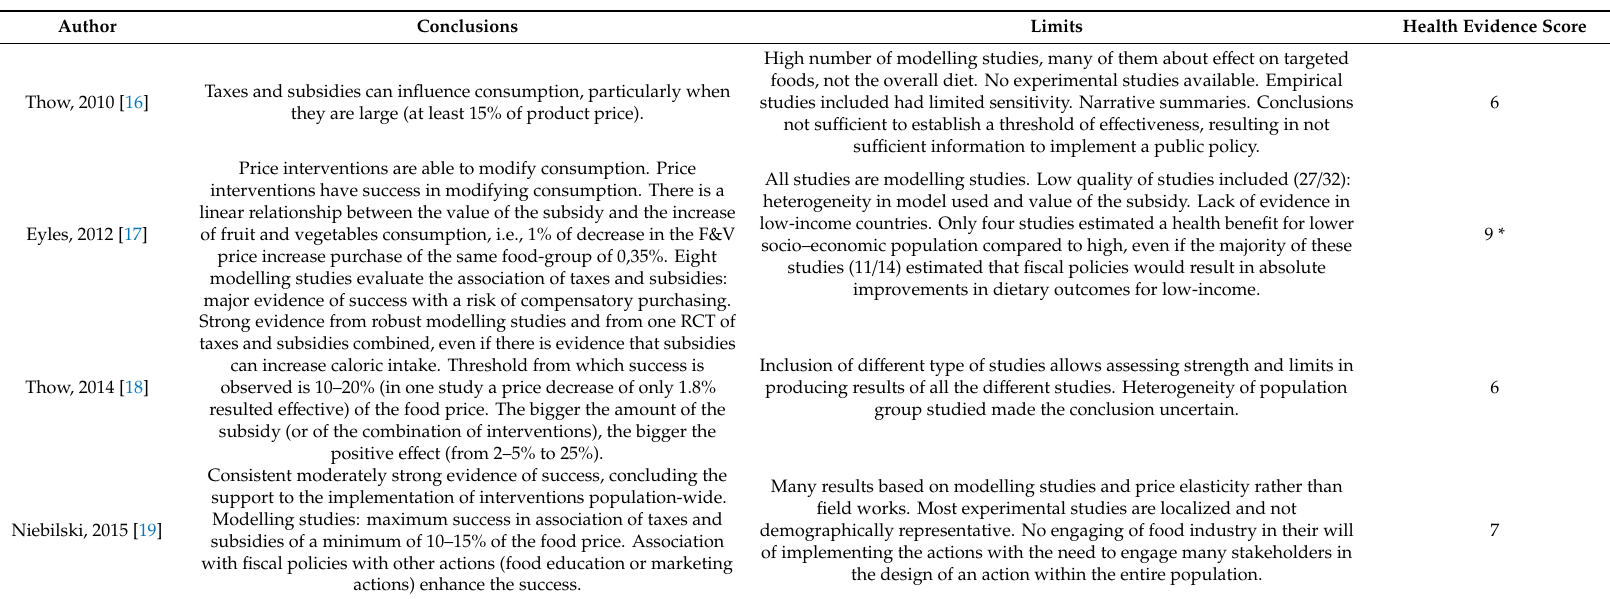
Table 4. Description of included review characteristics (RCT: randomized controlled trial; SES: socioeconomic status; AHA: American Heart Association; F&V: fruits and